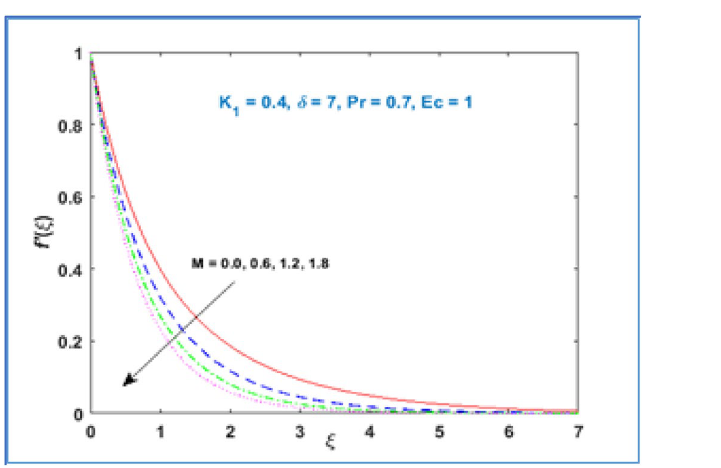
Figure 3. f ′ (ξ) versus M